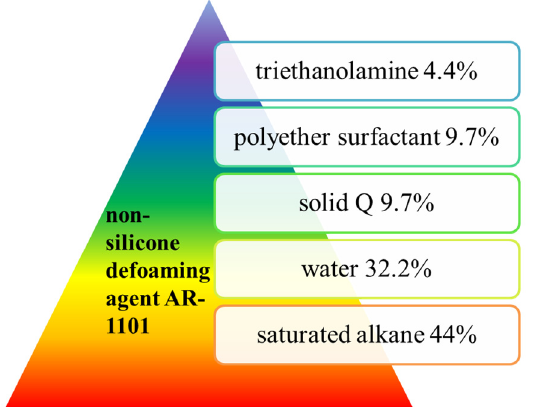
Figure 10. Raw materials for the preparation of a terpolymer-type non-silicone defoaming agent AR-1101.